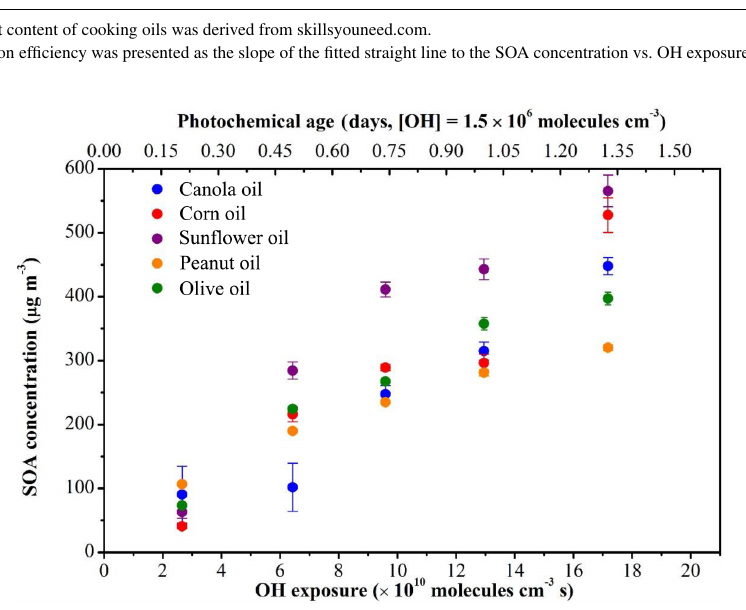
Figure 4. SOA concentration vs. OH exposure and photochemical age in days (at [OH] = 1 . 5 × 10 6 moleculescm − 3 ) during the aging of gas-phase emissions from different heated cooking oils. Error bars represent the standard deviation (1 σ